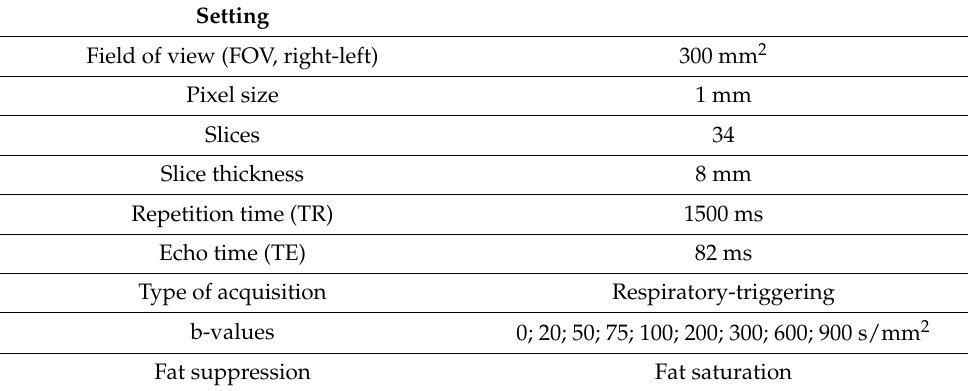
Table 1. DW-MRI settings. Setting Field of view (FOV, right-left) 300 mm 2 Pixel size Slices Slice